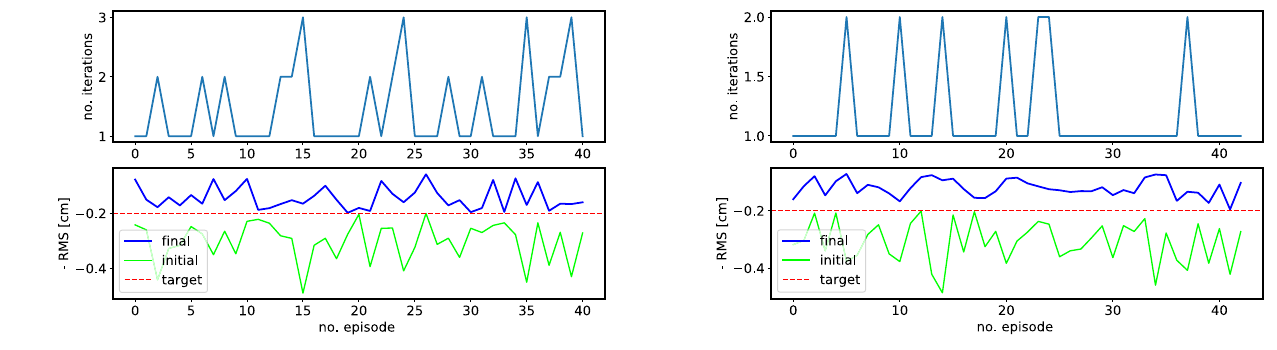
FIG. 9. Validation right after short training of 35 episodes on June 8, 2020. Despite the short training, the agent corrects the trajectory to better than the 2 mm RMS target within 1-3 iterations.